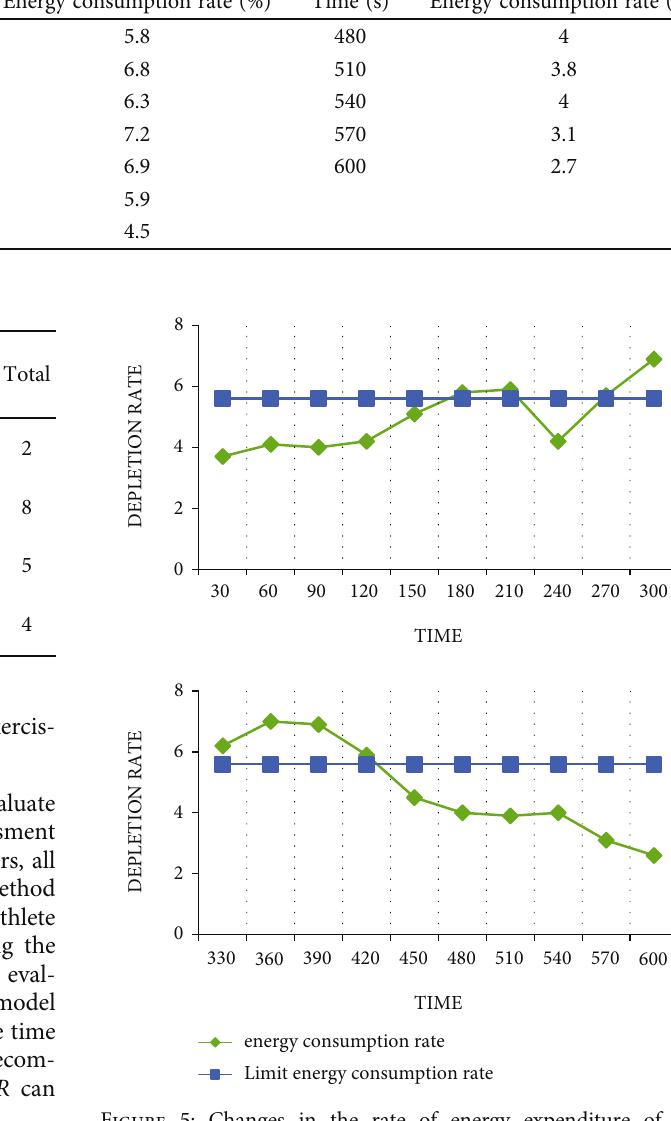
Figure 5: Changes in the rate of energy expenditure of the exerciser.